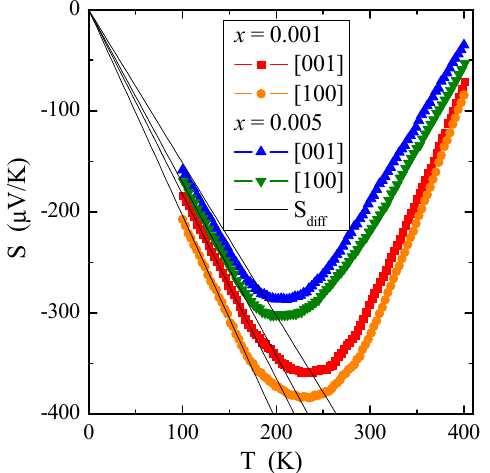
Figure 7. Thermoelectric power S vs. temperature T of PNMWO single crystals. S diff is the diffusion component of thermopower (marked with a solid line).